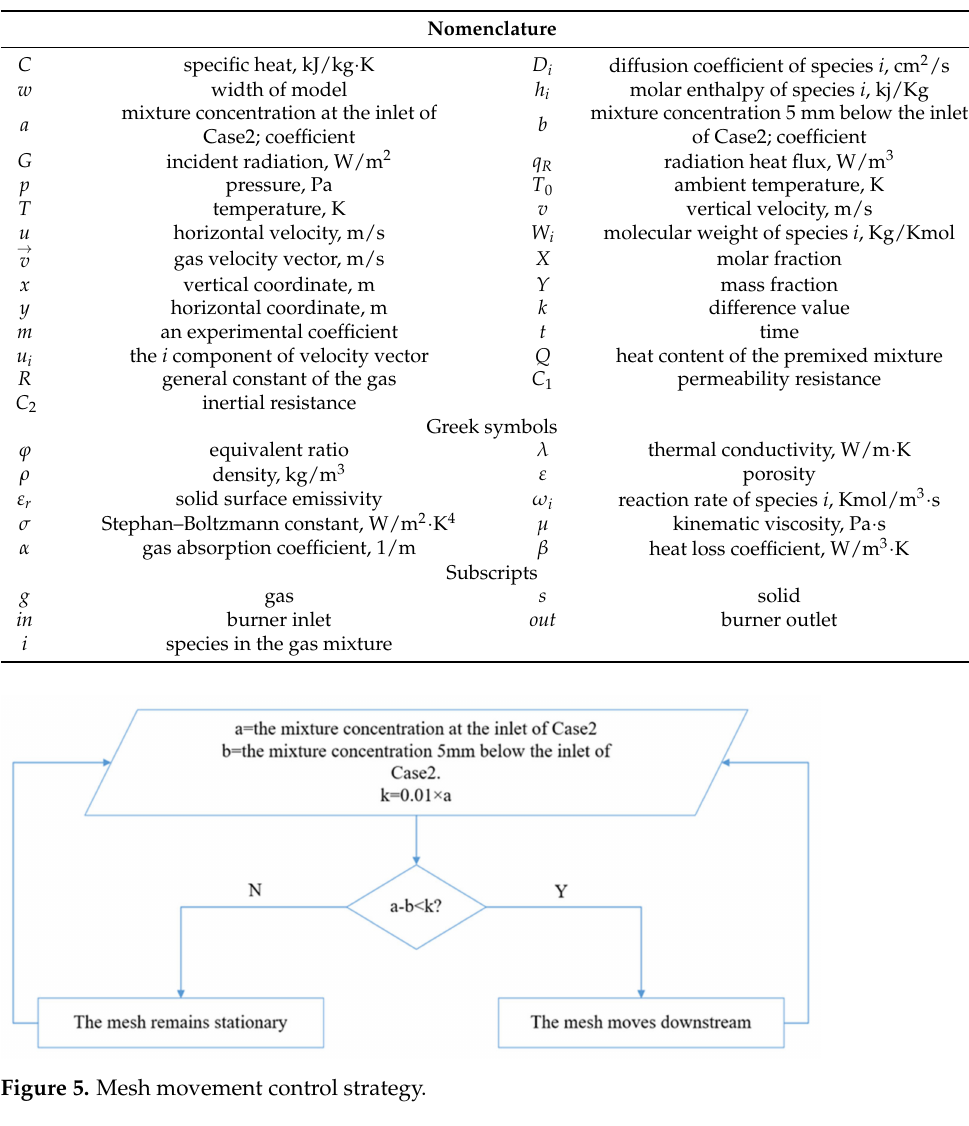
Table 1. Symbols used in this work.